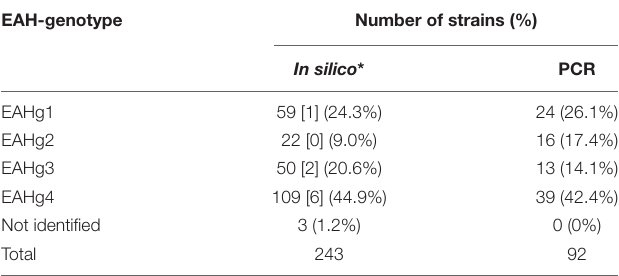
TABLE 2 | Summary of in silico - and PCR-based EAH genotyping.